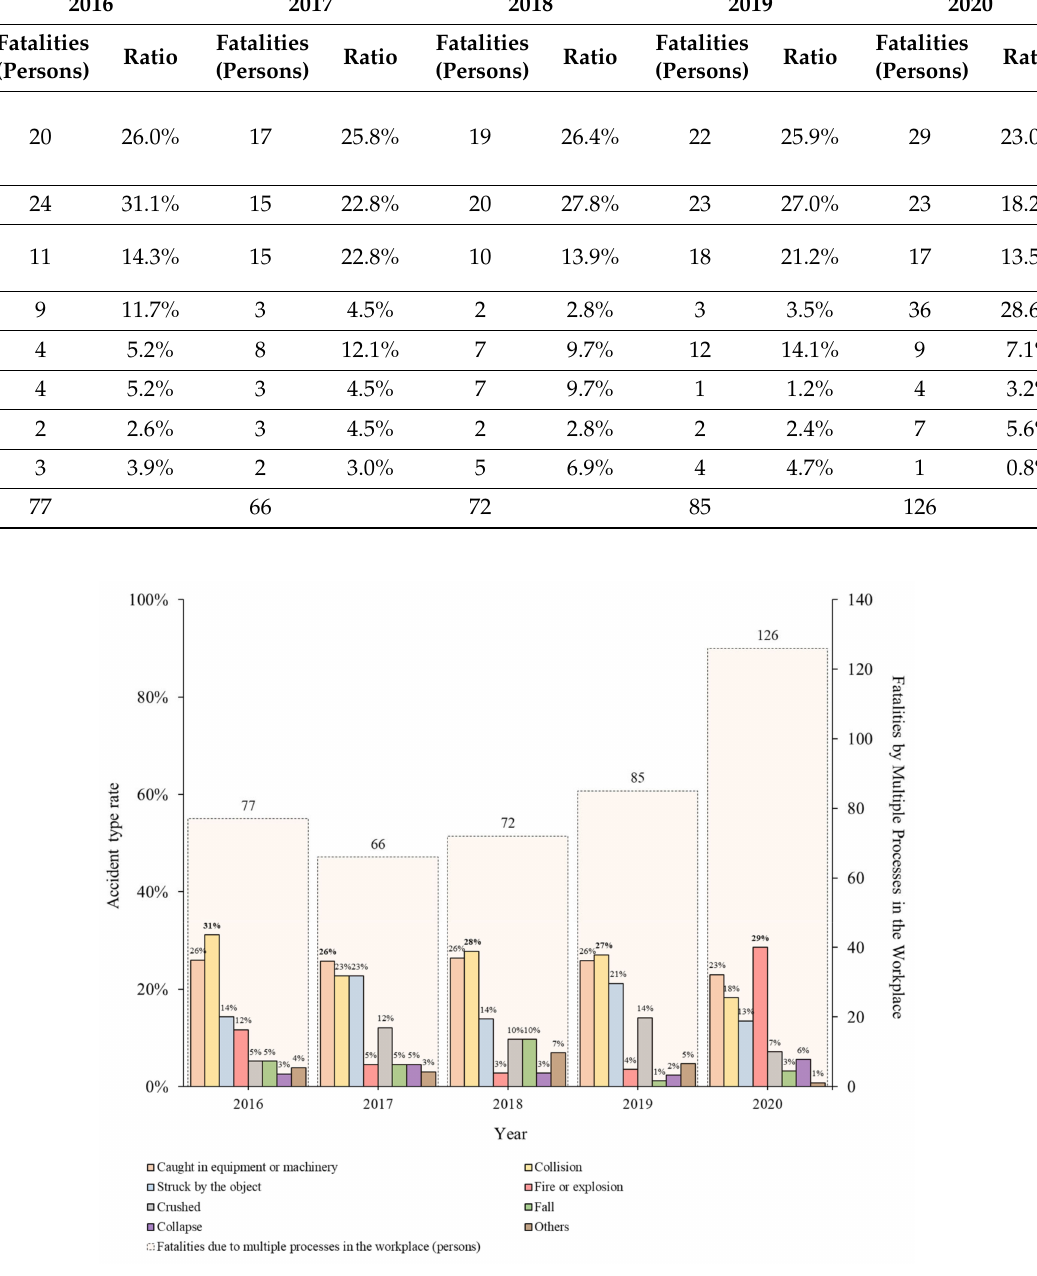
Figure 6. Percentage of types of fatalities caused by multiple processes in the workplace (2016–2020). Figures 7 and 8 show the distribution of sources of accidents caused by multiple processes in the workplace and the ratio based on the accident type, respectively, and the detailed causes were investigated based on the fatal accident investigation